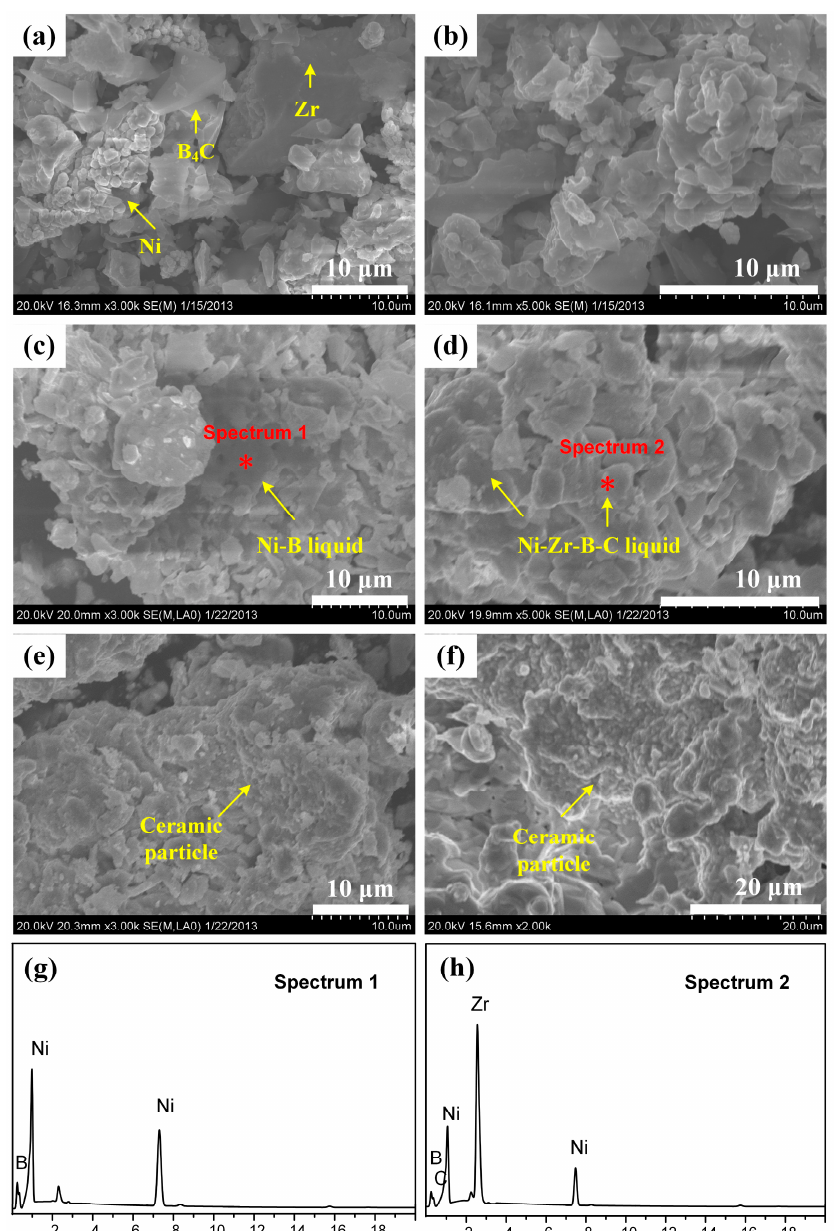
Figure 6. SEM micrographs for the DSC products of 30 wt.% Ni-Zr-B 4 C mixtures at ( a ) room temperature, quenched at ( b ) 900 °C; ( c ) 1060 °C; ( d ) 1100 °C; ( e ) 1170 °C; ( f ) 1200 °C; ( g,h ) the energy-dispersive spectrometry (EDS) spectra of ( c ) and ( d ).